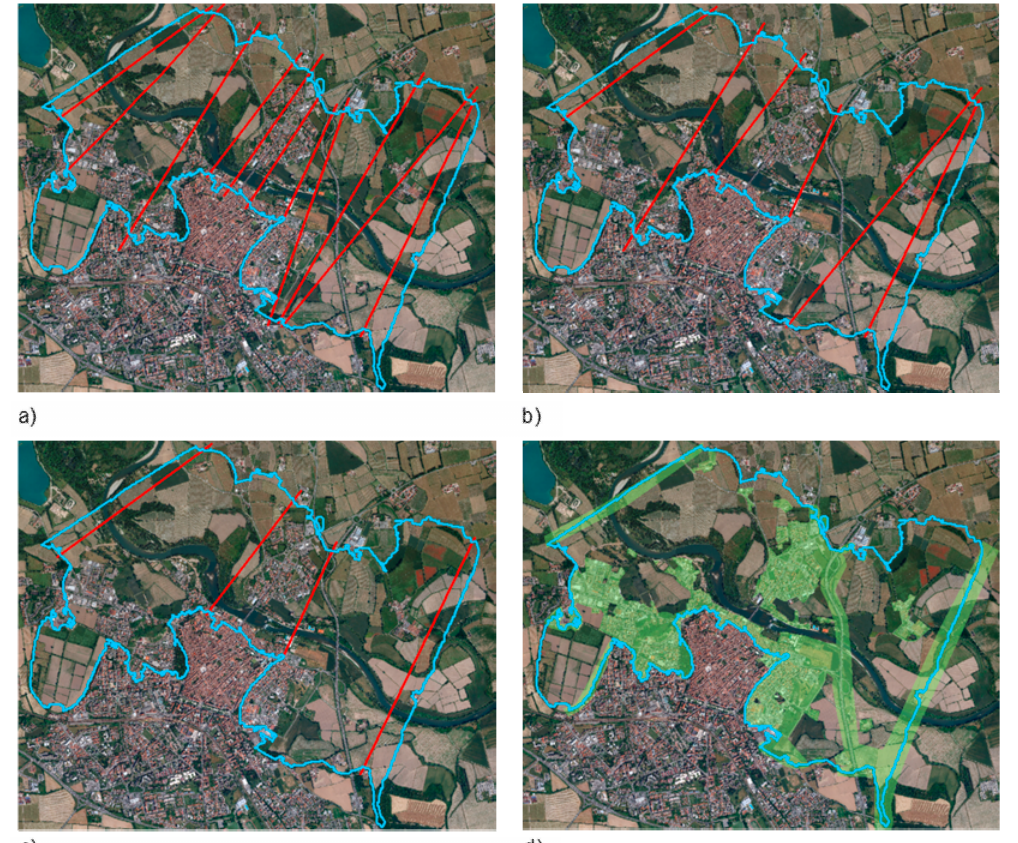
Figure 5. Cases considered in a sensitivity analysis of RAPIDE results to the spacing between auxiliary lines and the use of a mask: ( a ) ‘Narrow spacing’ case; ( b ) ‘Large spacing’ case; ( c ) ‘Very large spacing’ case; ( d ) Mask for filtering interpolation points in urban areas.